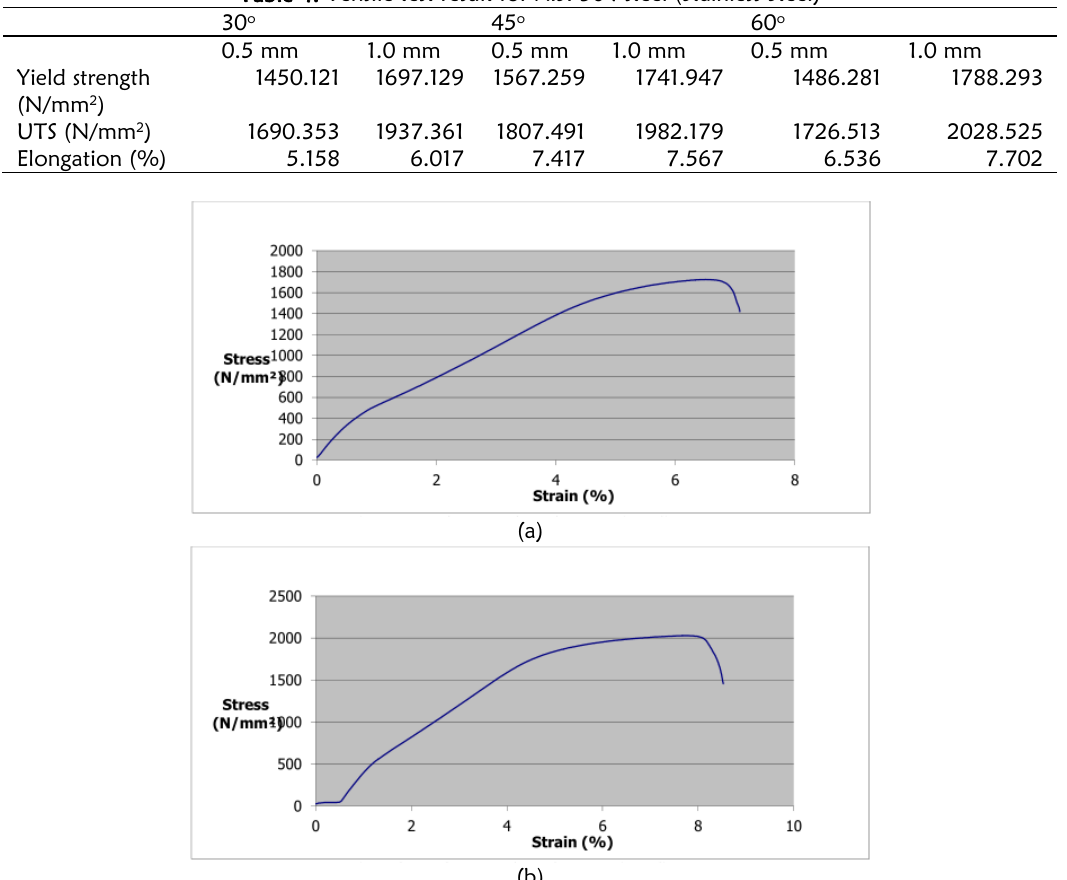
Figure 4: Stress against strain for Stainless Steel at 60° notch angle and (a) 0.5 mm, (b) 1.0 notch tip